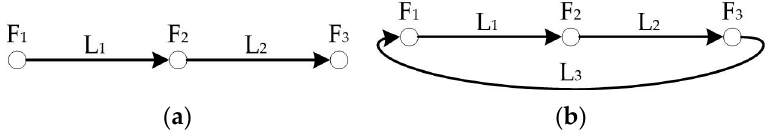
Figure 4. Function chains ( a ) function chain that performs one function; ( b ) function chain that performs multiple functions.